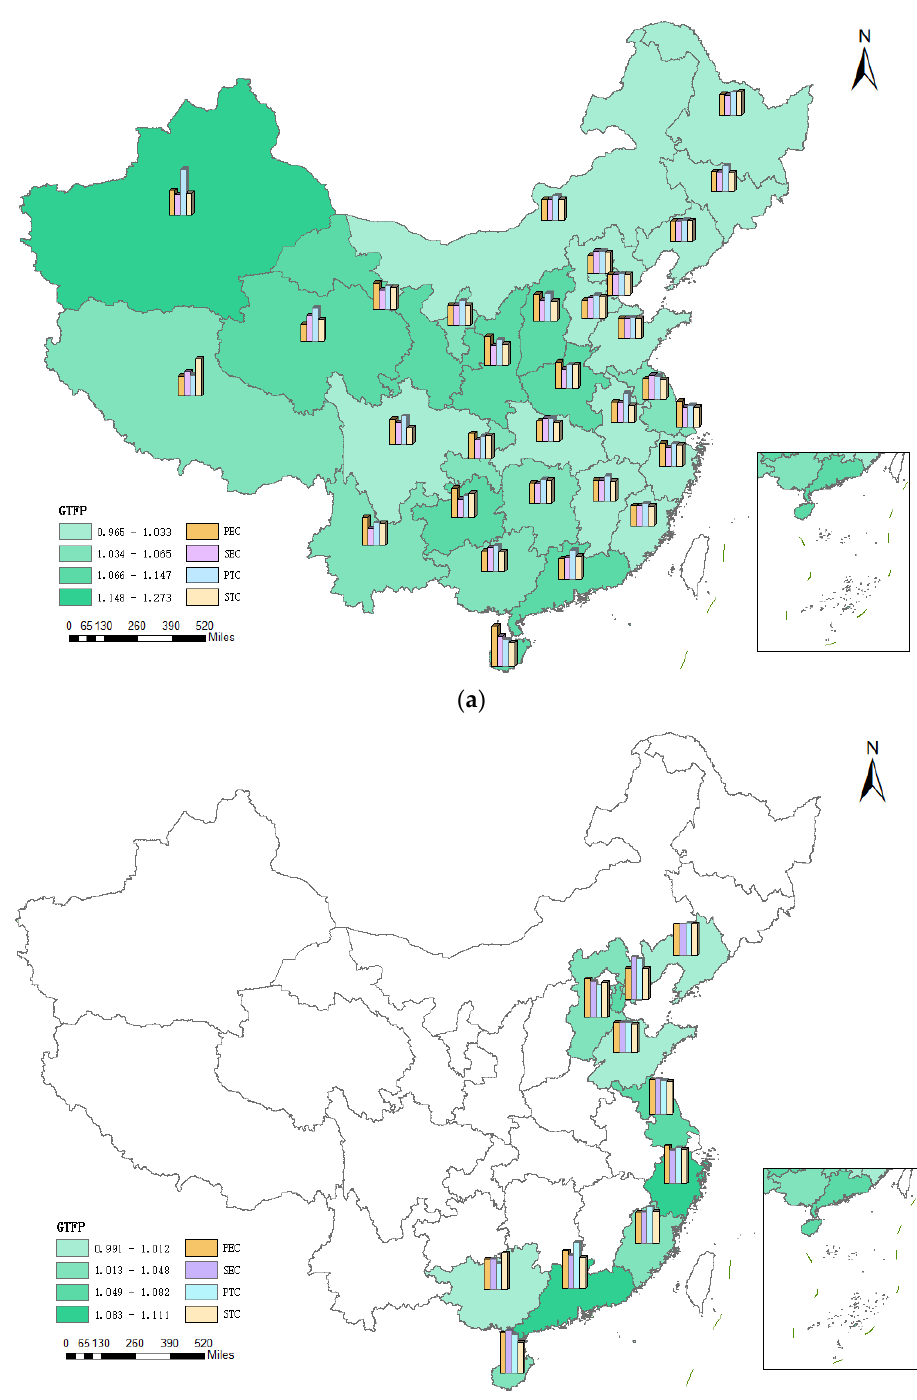
Figure 6. ( a ). The GTFP and Zofio index decomposition of freshwater aquaculture in China. ( b ). The GTFP and Zofio index decomposition of mariculture in China.